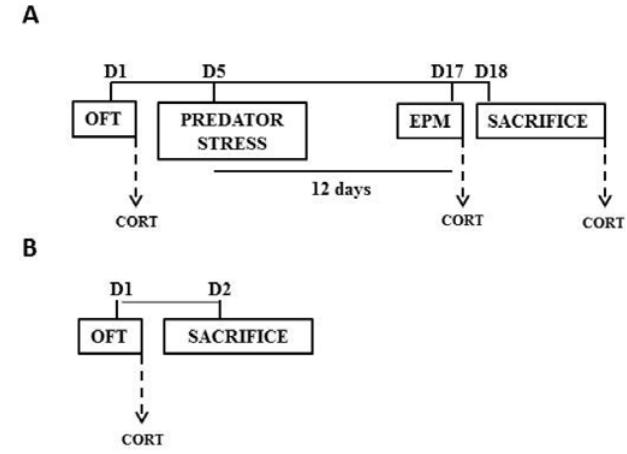
Figure 1. Schematic of experimental flow. ( A ) Animals were sequentially tested for anxiety in the open ‐ field arena (OFT), exposed to predator stress and subsequently exposed to an elevated plus maze (EPM). Blood for corticosterone estimates was drawn thirty minutes after OFT, EPM, and the animals were eventually sacrificed for morphological endpoints. Days elapsed from the start of the experiment are denoted on top. ( B ) A separate cohort was exposed to open field and sacrificed the next day for morphological endpoints. Blood was collected 30 min after OFT for hormone measurement.